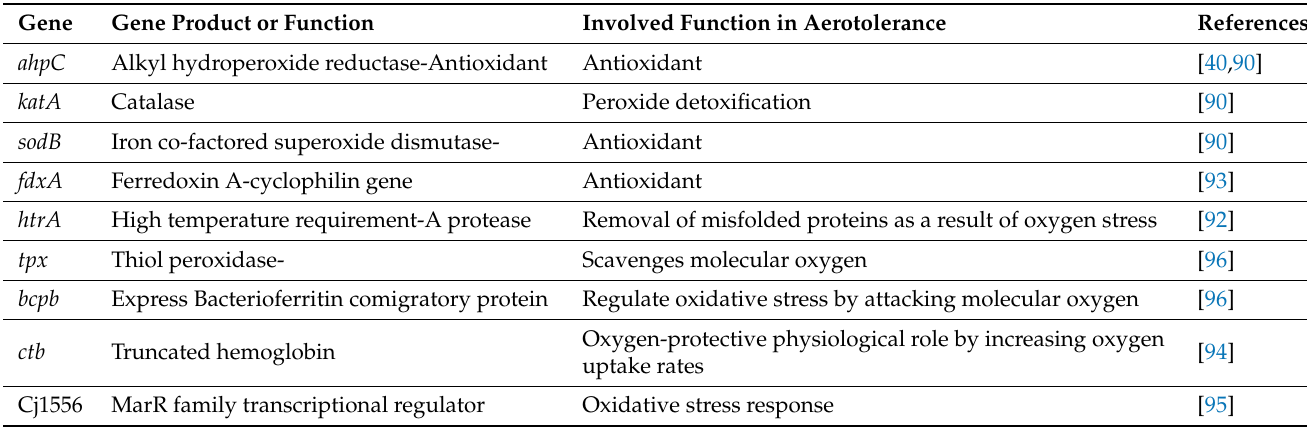
Table 3. Cluster of genes involved, and its potential function in aerotolerance mechanism in Campylobacter jejuni